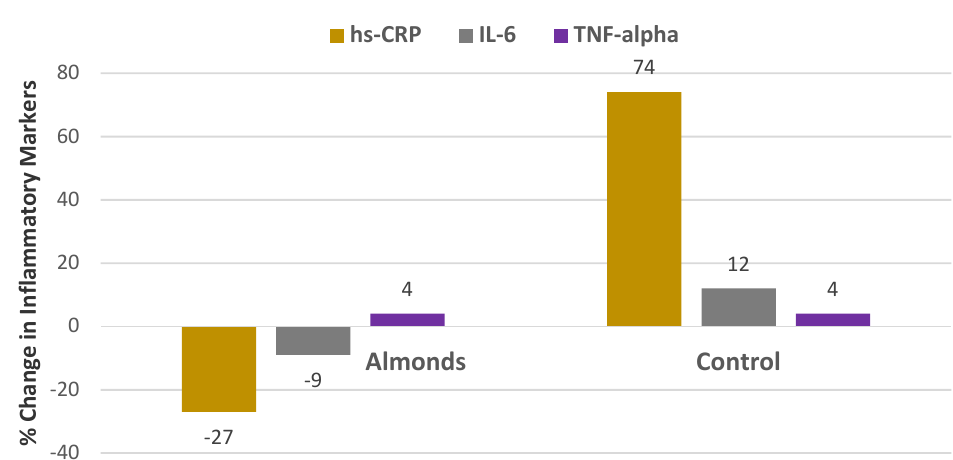
Figure 33. The almond snack significantly lowered hs-CRP ( p = 0.029) and other inflammatory markers ( p > 0.05) vs. the control diets from baseline to 6 weeks ( p > 0.05) [34]. Cohen and Johnston [39] conducted two RCTs: (1) A pilot parallel RCT randomly assigned 13 obese subjects with T2 diabetes (54% men, mean age 66 years, mean BMI 35) to an isocaloric diet supplemented with one serving of almonds (28 g/day, approximately 160 kcals) or two cheese sticks (160 kcals) for 5 days/week for over 12 weeks. The almond snack significantly lowered hbA1c by − 5.0% compared to the cheese snack. (2) In an acute RCT, 12 non-diabetic and 7 diabetic individuals consumed a standardized dinner (sub sandwich, chips, and soda) followed by a 12 h overnight fast, after which they were assigned to an isocaloric early morning breakfast consisting of a white bagel with butter and berry juice (control) or the same meal with 28 g of almonds replacing butter. Blood draws were taken at 0, 30, 60, 90, and 120 min. In T2 diabetic individuals, the almond diet significantly reduced postprandial glycemia with − 30% lower AUC over 120 min ( p = 0.043) and reduced peak glucose level by − 0% ( p = 0.046) compared to the control diet. gLP-1, which helps to activate pancreatic beta-cell insulin secretion, at 30 min post-meal, was insignificantly increased by 28% vs. the control diet. These two small trials provide support for almonds as a healthy snack for individuals with T2